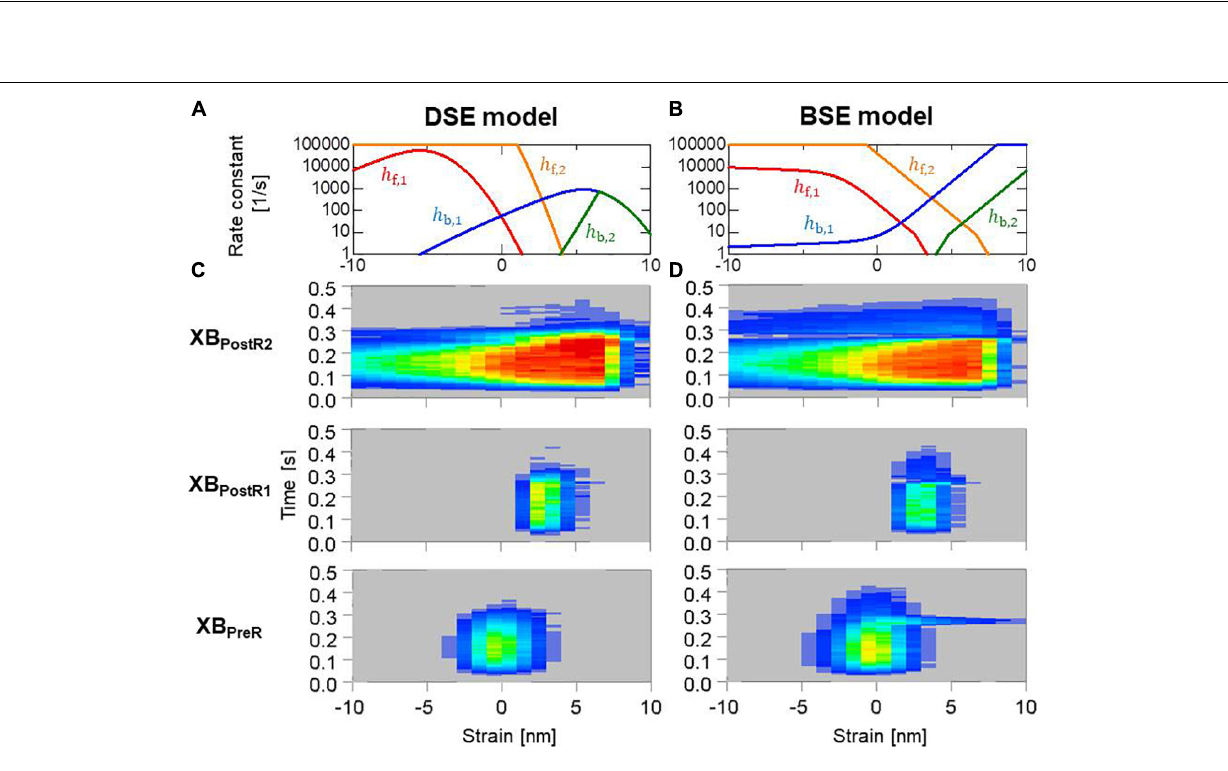
Frontiers in Physiology |